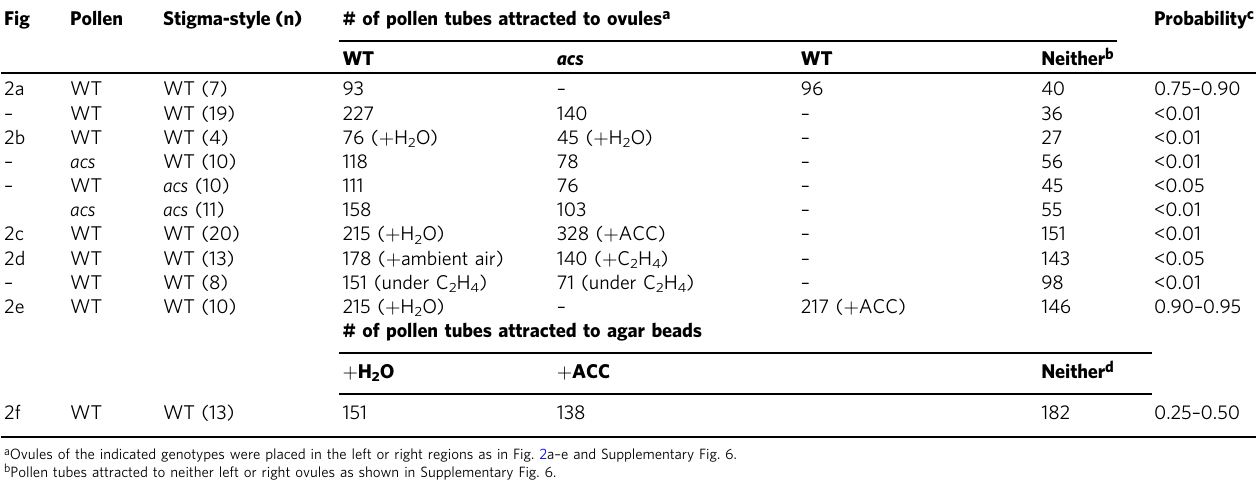
Table 1 Quanti fi cation of pollen tube attraction in the semi-in vivo pollen tube guidance assay. Fig Pollen Stigma-style